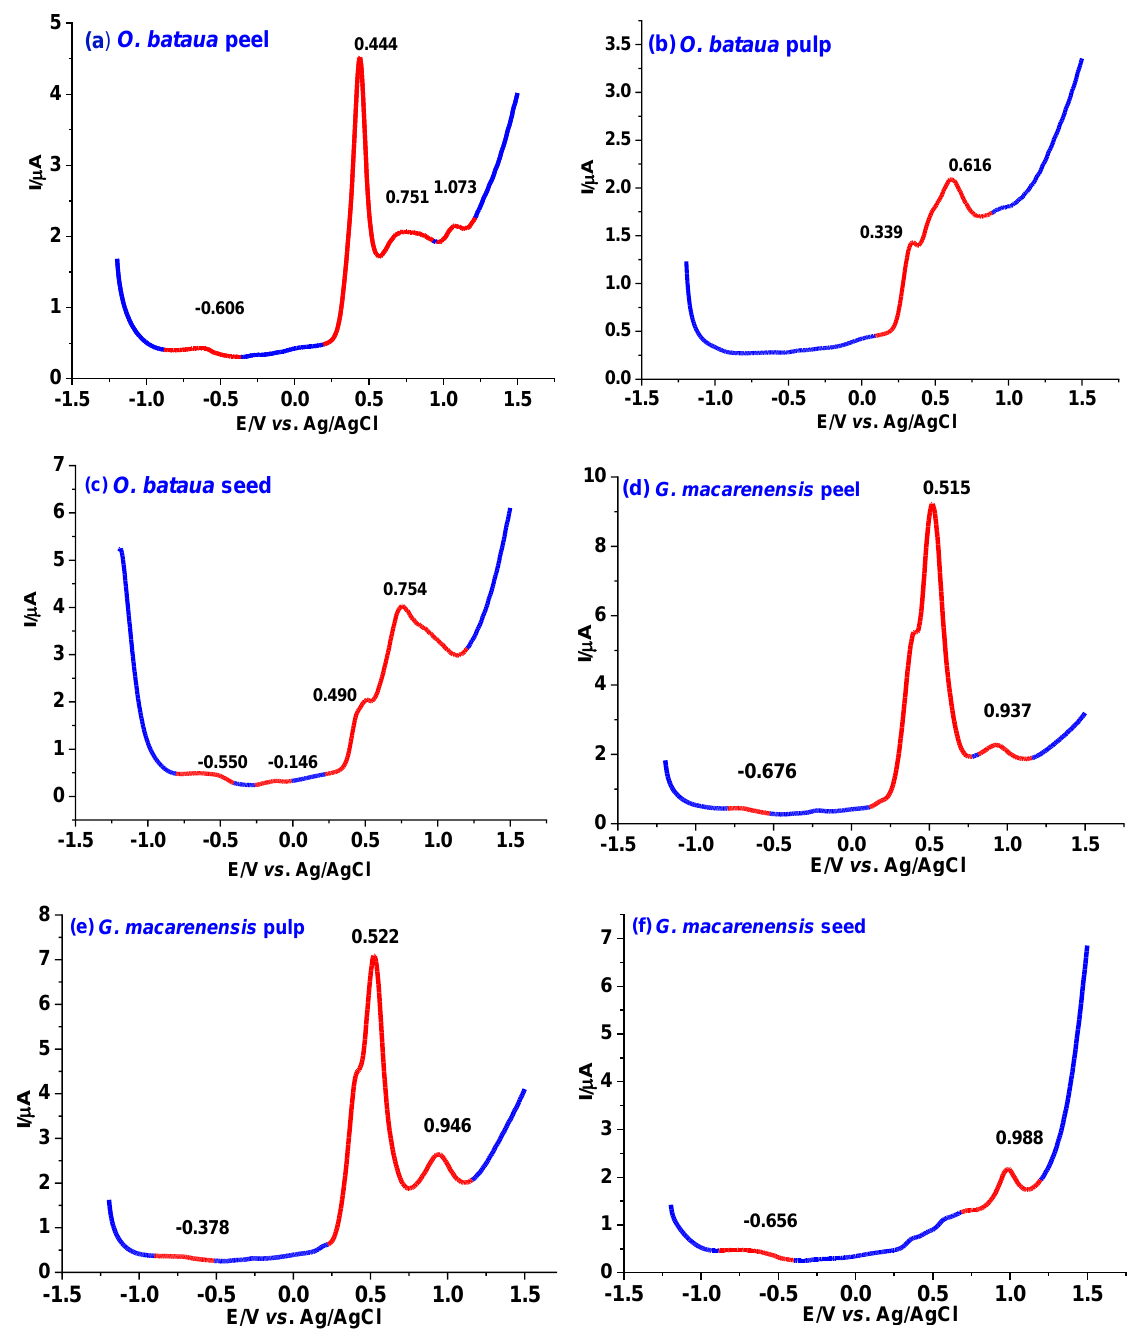
Figure 3. Differential pulse voltammograms for the ethanolic extracts of ( a ) O. bataua peel, ( b ) O. bataua pulp, ( c ) O. bataua seed, ( d ) G. macarenensis peel, ( e ) G. macarenensis pulp, and ( f ) G. macarenensis seed in acetate buffer, pH 4.5, and a scan rate of 17 mV/s.